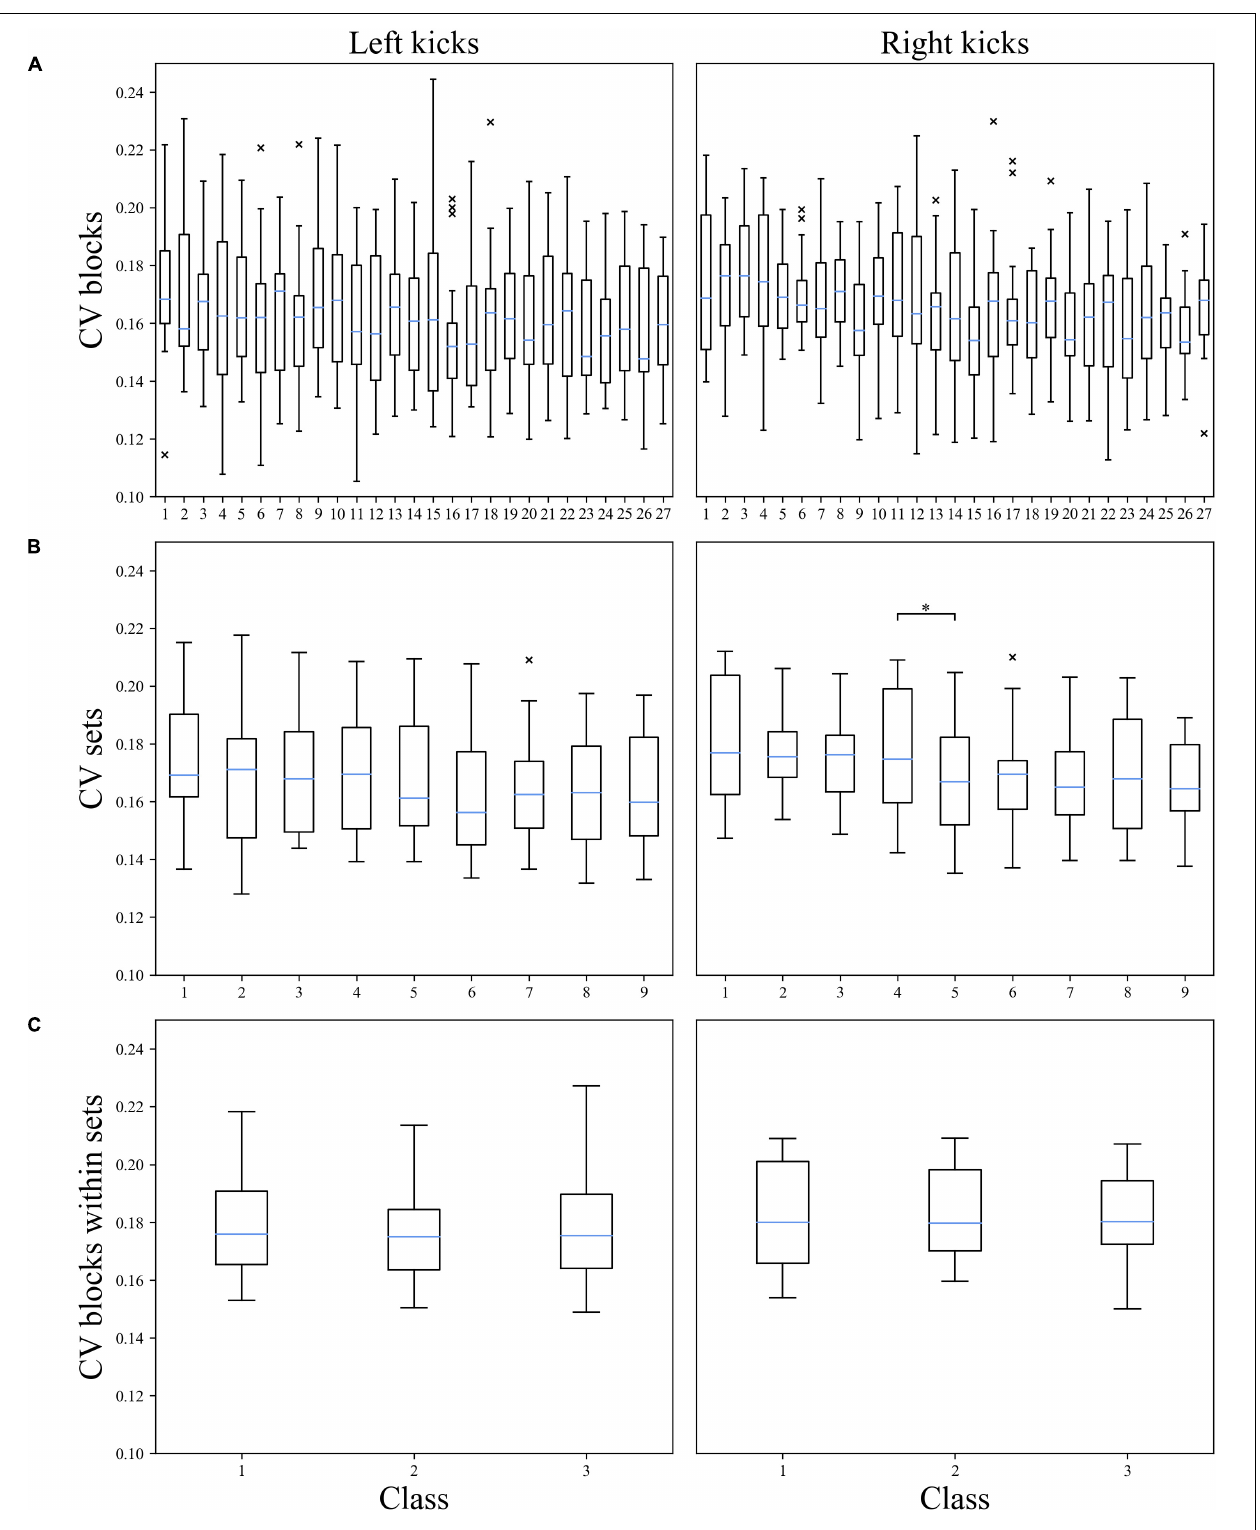
FIGURE 5 | Coefficient of variations of the joint angle waveform of the left and right kicks depending on each block and set. Presented here are the box plots for all participants; the x -axis shows the classes, and the y -axis shows the CV. Values are considered as outliers if they are outside the interval [ Q 1 – 1.5 * ( Q 3 – Q 1 ), Q 3 + 1.5 * ( Q 3 – Q 1 )]. × = Outlier (each × stands for one outlier); *Statistically significant difference in pairwise post hoc test. (A) CV of the waveforms of the blocks of each participant. There was a statistically significant result for right kicks. (B) CV of the waveforms of the sets of each participant. There was a statistically significant result for right kicks. (C) CV of the waveforms of the blocks within sets for all participants.